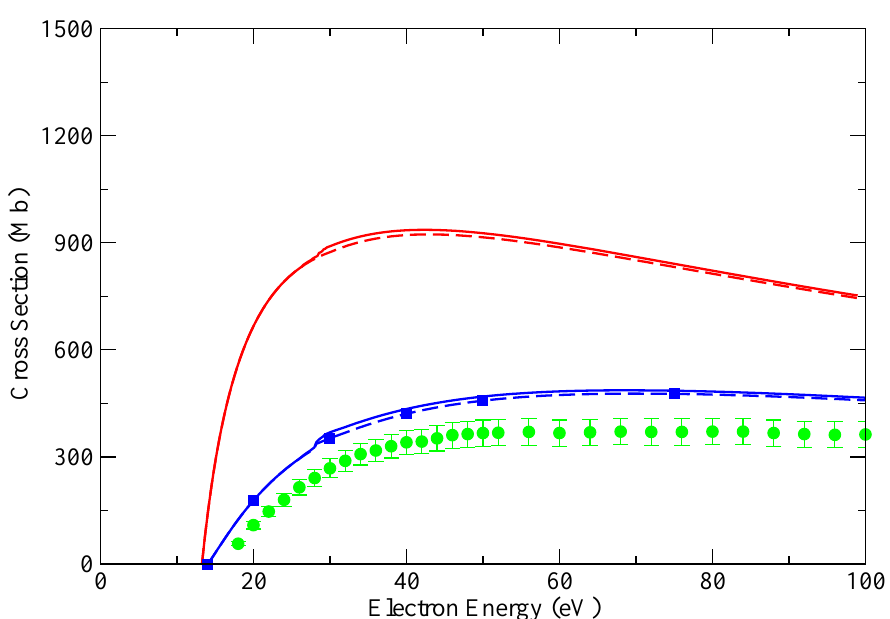
Figure 3. Electron-impact ionization of Kr. Dashed line (red): direct ionization of the 4 p and 4 s subshells using the CADW method, solid line (red): direct ionization of the 4 p and 4 s subshells using the CADW method plus all 4 s → nl excitations, dashed line with squares (blue): Direct ionization of the 4 p and 4 s subshells using the TDCC method, solid line (blue): direct ionization of the 4 p and 4 s subshells using the TDCC method plus all 4 s → nl excitations, circles (green): crossed-beams measurements [8], (1.0 Mb = 1.0 × 10 − 18 cm 2